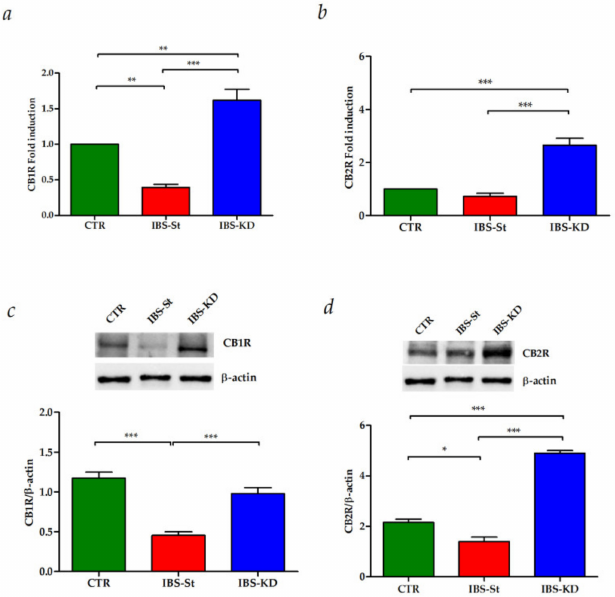
Figure 2. ( a ) CB1 gene expression levels in the control group (CTR), IBS rats fed a standard diet (IBS-St), and IBS rats treated with low-carbohydrate, high-fat ketogenic diet (IBS-KD). ( b ) CB2 gene expression levels in the control group (CTR), IBS rats fed a standard diet (IBS-St), and IBS rats treated with low-carbohydrate, high-fat ketogenic diet (IBS-KD). ( c ) CB1 protein expression levels and representative blots from the control group (CTR), IBS rats fed a standard diet (IBS-St), and IBS rats treated with low-carbohydrate, high-fat ketogenic diet (IBS-KD). ( d ) CB2 protein expression levels and representative blots from the control group (CTR), IBS rats fed a standard diet (IBS-St), and IBS rats treated with low-carbohydrate, high-fat ketogenic diet (IBS-KD). All data represent the results of three different experiments (mean ± SD). p -value was determined by ANOVA with Tukey’s multiple comparison test * p <0.05, ** p < 0.01, and *** p <